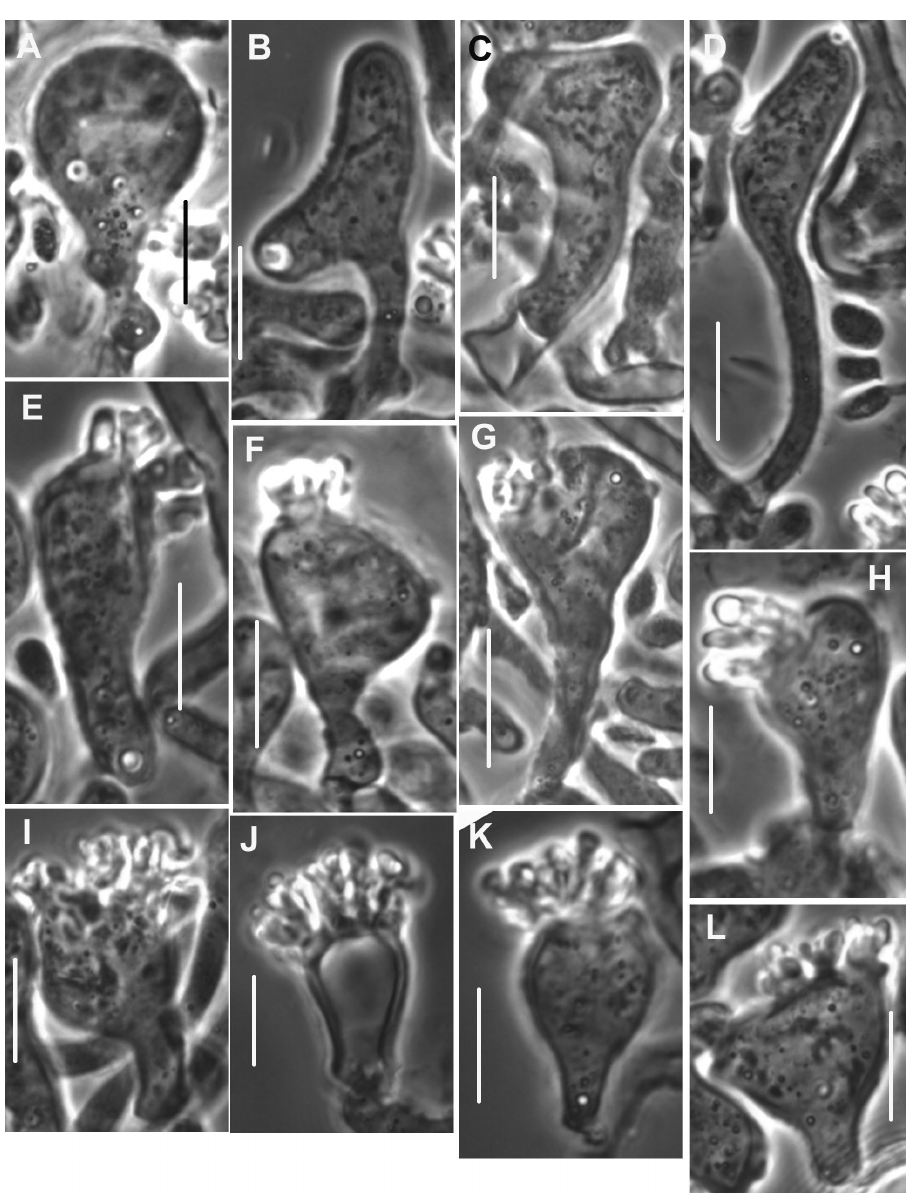
Figure 71. Mycetinis scorodonius . Pileus margin pileipellis elements. A–D Inflated elements E–L Broom cell-like elements. Standard bar = 20 mm. TFB 14229 (TENN-F- 68086). brownish orange 6C4, when moist brown, yellow-brown or ochre, sometimes paler towards margin; margin slightly involute then more or less straight, undulating, dis- tinctly pallescent on drying to pale brown 6D5, pale ochraceous, “pale ochraceous buff” 4A2, “pale pinkish cinnamon” 6A2, pinkish, “pinkish buff” 6A3, or dirty